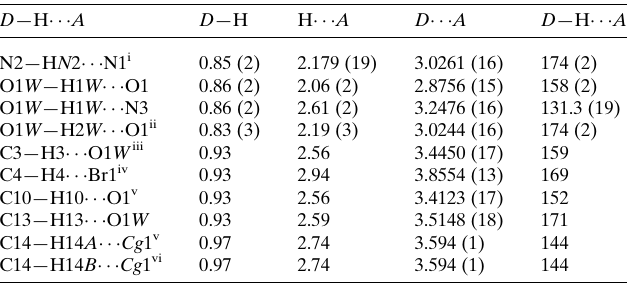
Table 3 Hydrogen-bond geometry (A˚ , (cid:3) ) for (I). Cg 1 is the centroid of N1/C1–C5 pyridine